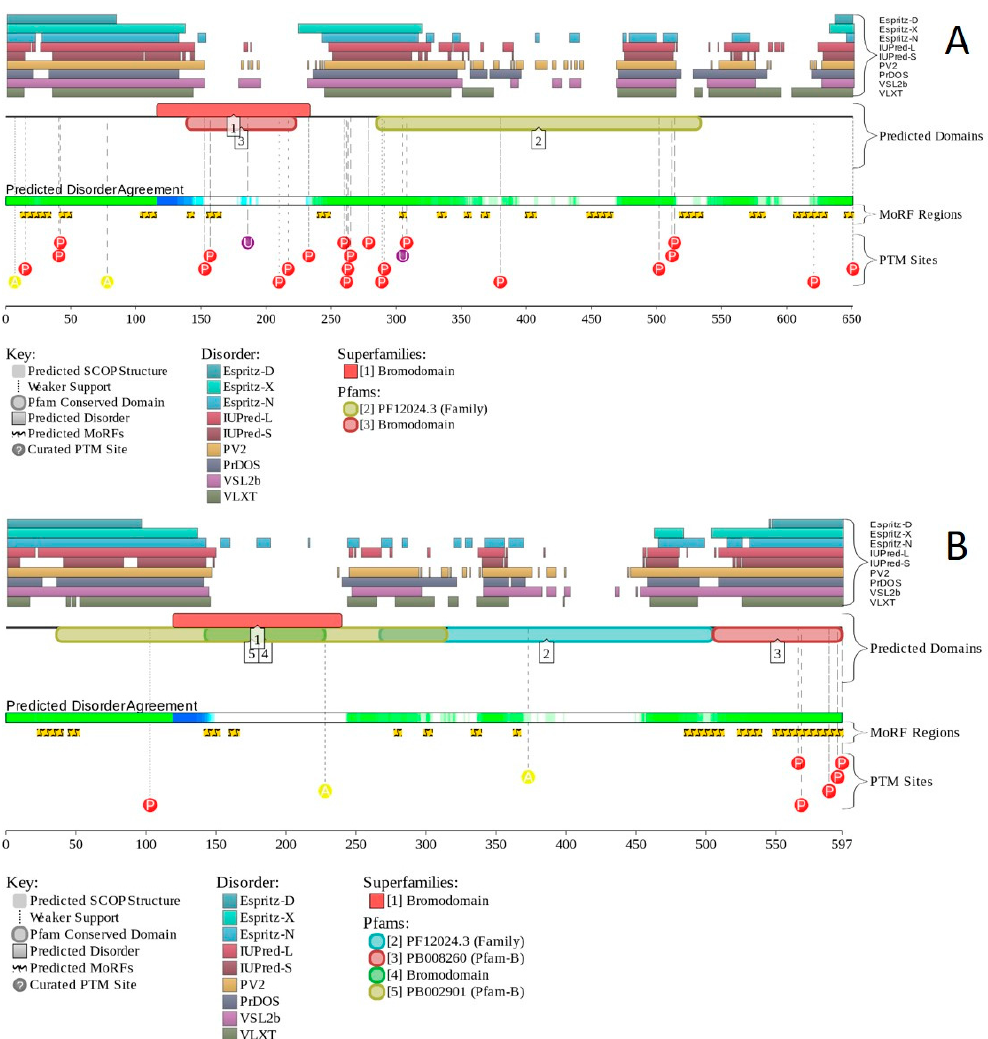
Figure 18. Structure, intrinsic disorder, and functionality of human BRD7 and BRD9. ( A ) D 2 P 2 functional disorder profile of human BRD7 (UniProt ID: Q9NPI1). ( B ) D 2 P 2 functional disorder profile of human BRD9 (UniProt ID: Q9H8M2).